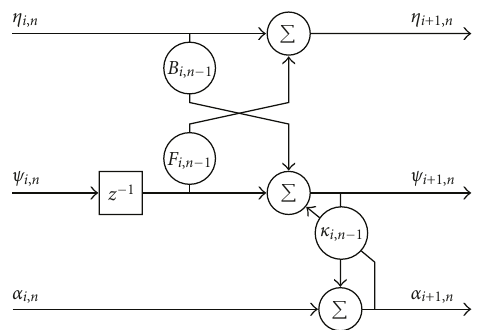
Figure 1: Data flow graph of one order update step of the